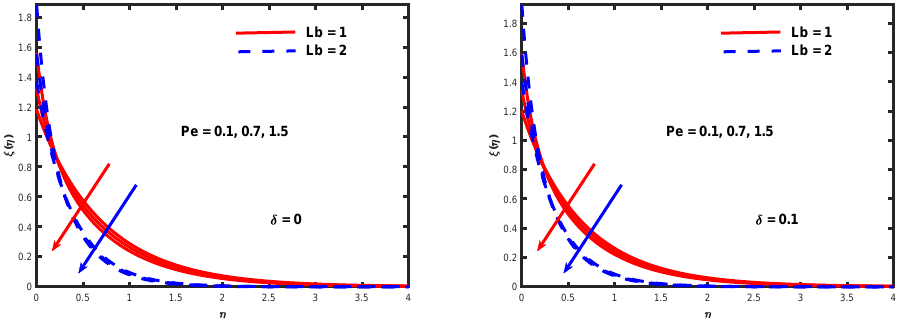
Figure 18. Influence of bioconvection Peclet numeral and bioconvection Lewis number on ξ